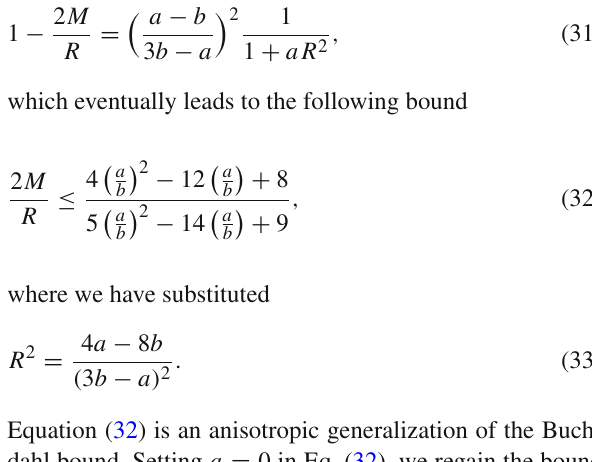
on compactness. Setting K = 0, we regain the bound 2 M / R ≤ 8 /